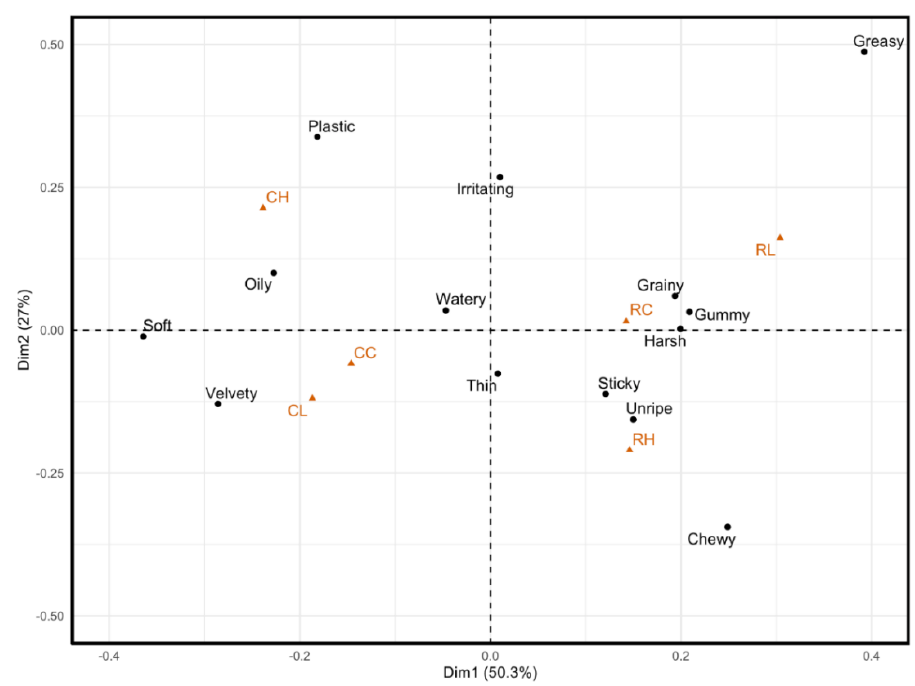
Figure 7. Corresponding analysis using CATA data. CATA terms are in black and wine treatments are in orange.